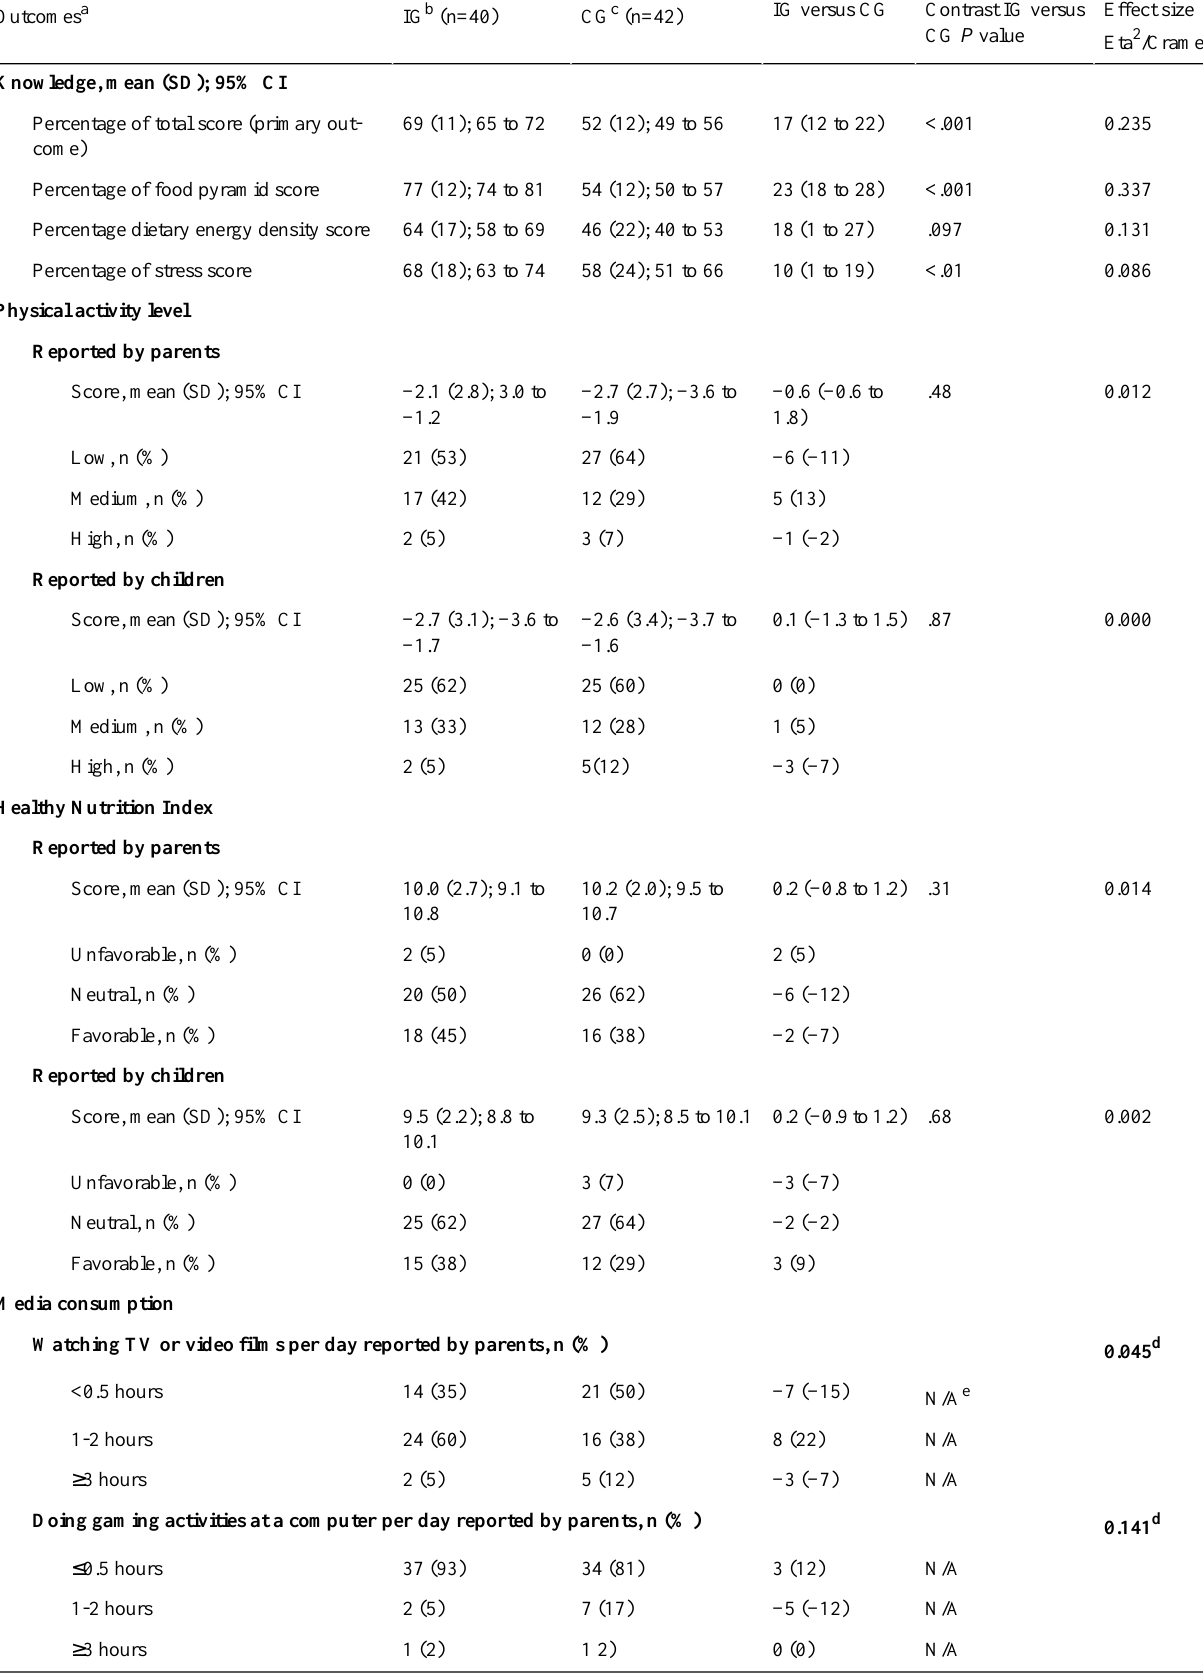
Table 2. Outcomes from the intention-to-treat